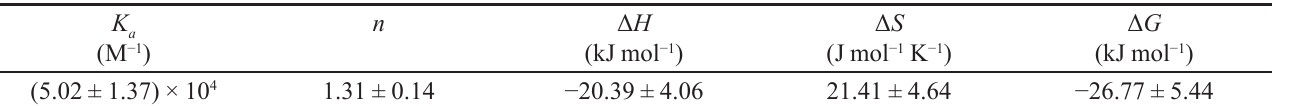
TABLE I - Binding and thermodynamic parameters of the interaction between 6-shogaol and HSA derived from ITC measurements at pH 7.4 and 25 °C